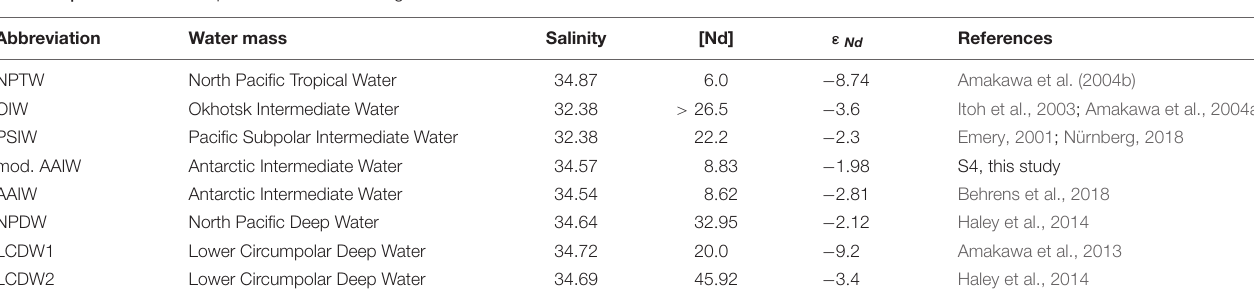
FIGURE 6 | Mixing relationships of major intermediate water masses (25.8 < σ θ < 27.4) in the North Pacific based on ε Nd and salinity (A) and ε Nd and [Nd] (B) . NPTW and OIW represent waters of the Kuroshio and the Oyashio respectively. PSIW reflects values at station 39-1 whereas mod AAIW is intermediate water found at station S4. Calculated mixing lines between the four end-members ( Table 3 ) with 10% increments (black dots) are displayed. TABLE 3 | End-member compositions used for mixing